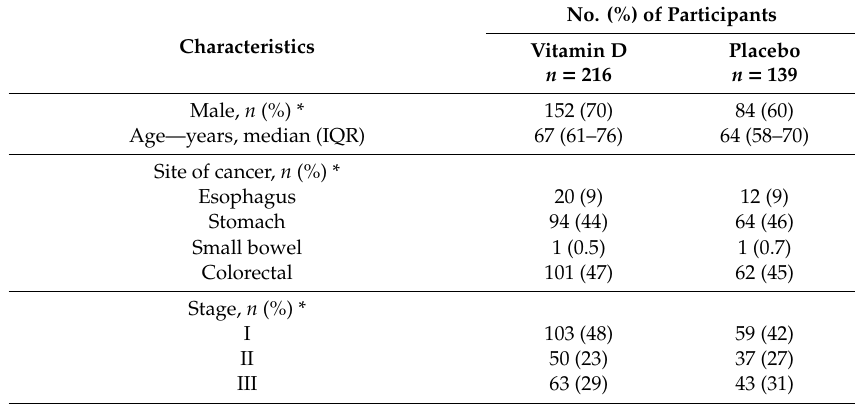
Table 1. Participants’ characteristics and serum 25(OH)D-related variables used in this post hoc